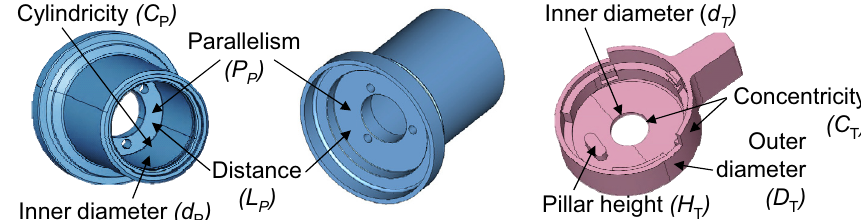
Fig. 1. Pipe connector (left and middle) and Toggle (right). The selected measurands are indicated.